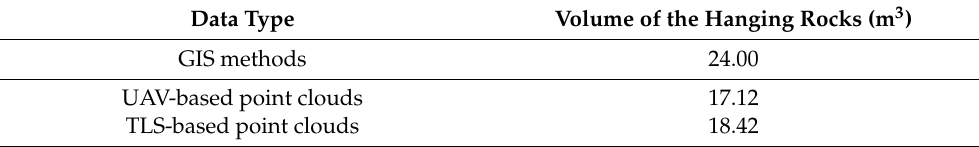
Table 5. Estimation of the volume of the hanging rocks using UAV/TLS point